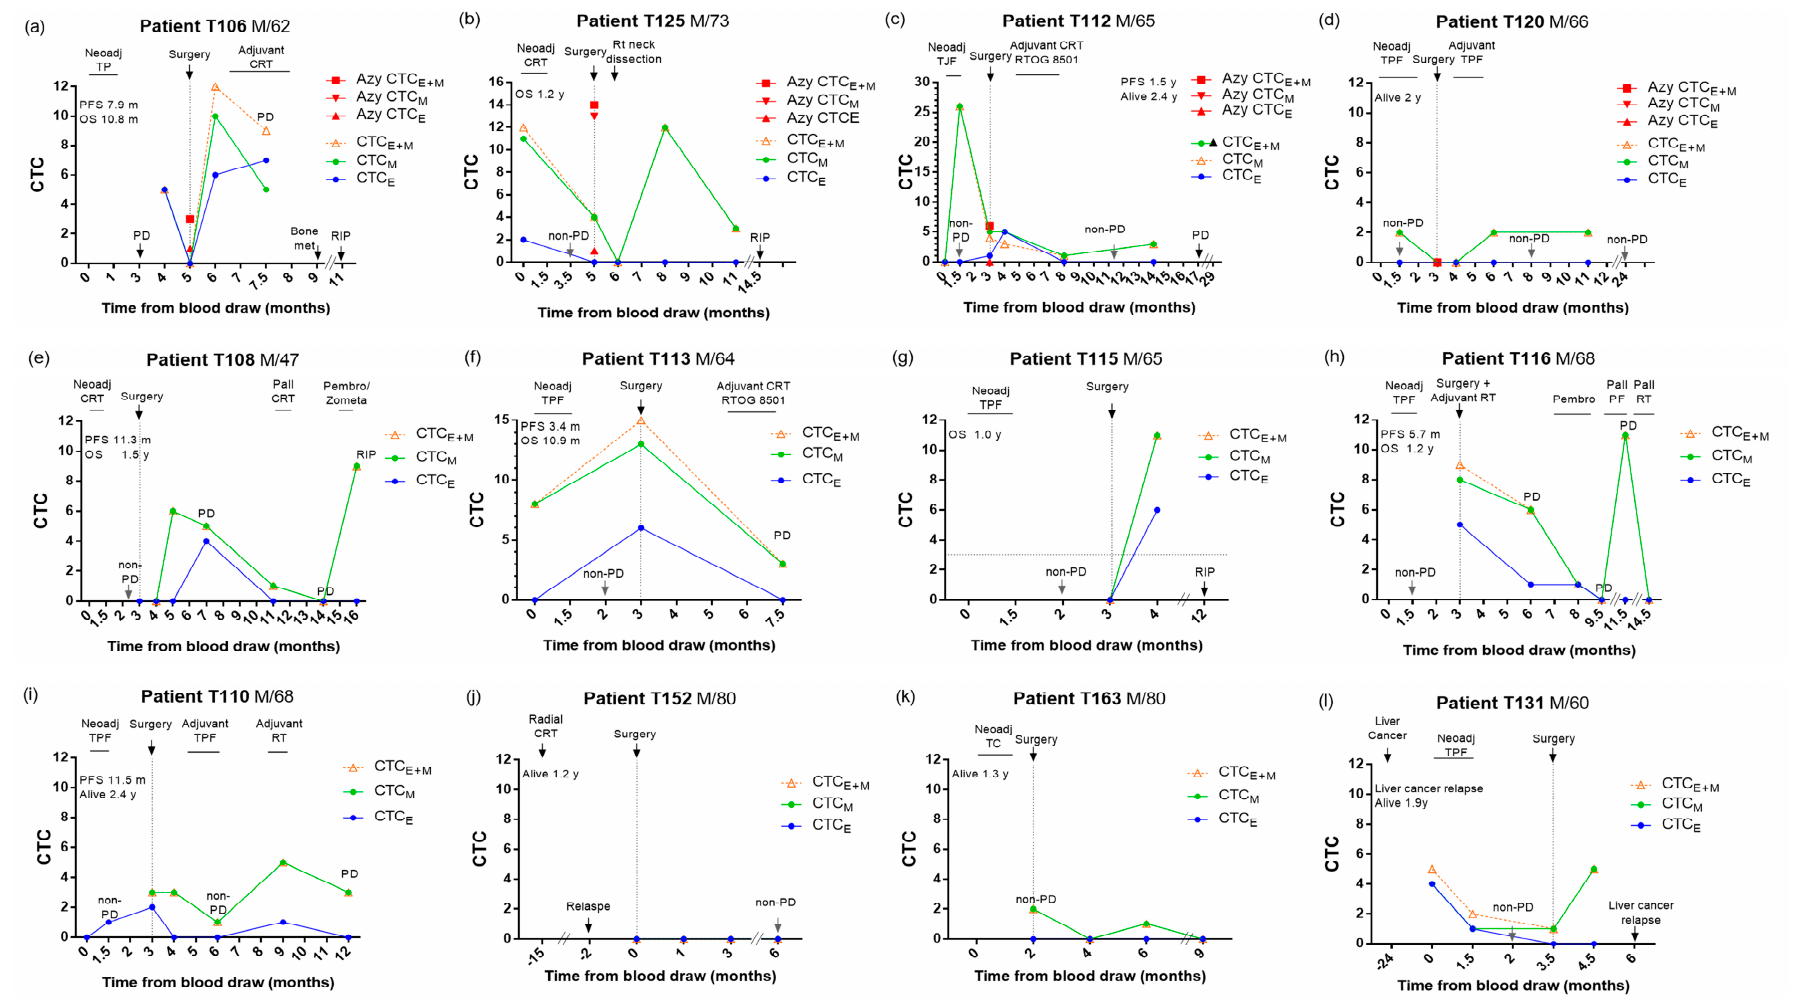
Figure 4. Longitudinal monitoring of epithelial and total CTC changes in response to therapy for 12 patients. M: male; RTOG: Radiation Therapy Oncology Group;